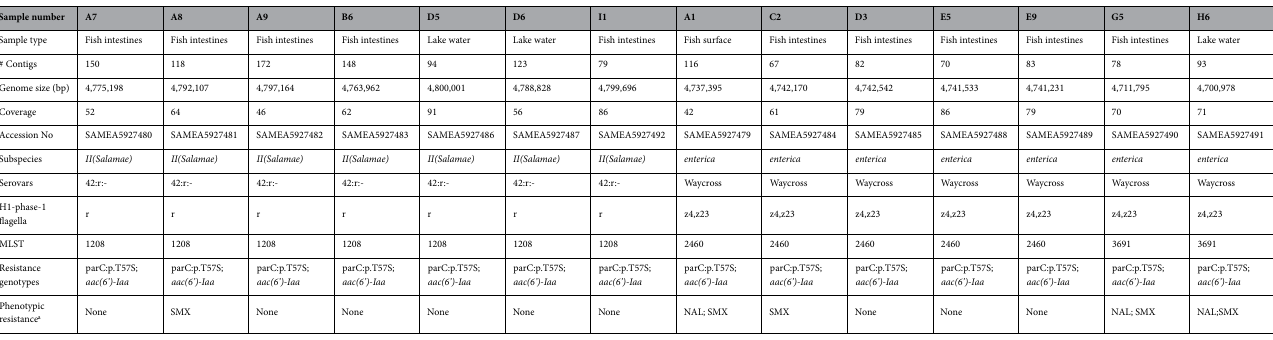
Table 1. Genomic characteristics of S. Salamae 42:r:- and S. Waycross. a NAL, nalidixic acid; SMX,